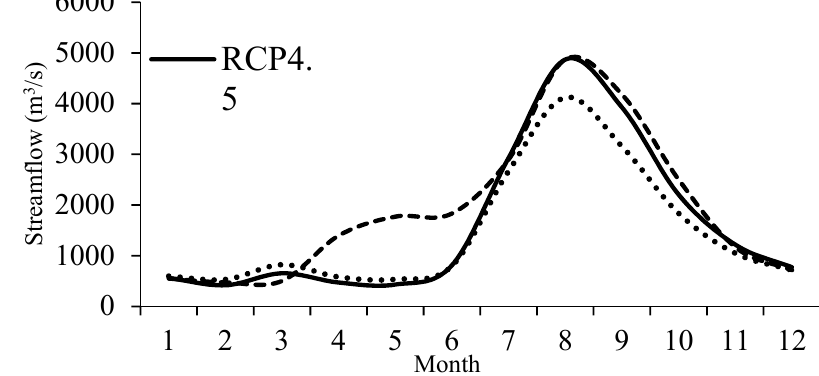
Figure 7. Intra ‐ annual changes of discharge in the Songhua River Basin (at Jiamusi Station) for 1980– Figure 7. Intra-annual changes of discharge in the Songhua River Basin (at Jiamusi Station) for